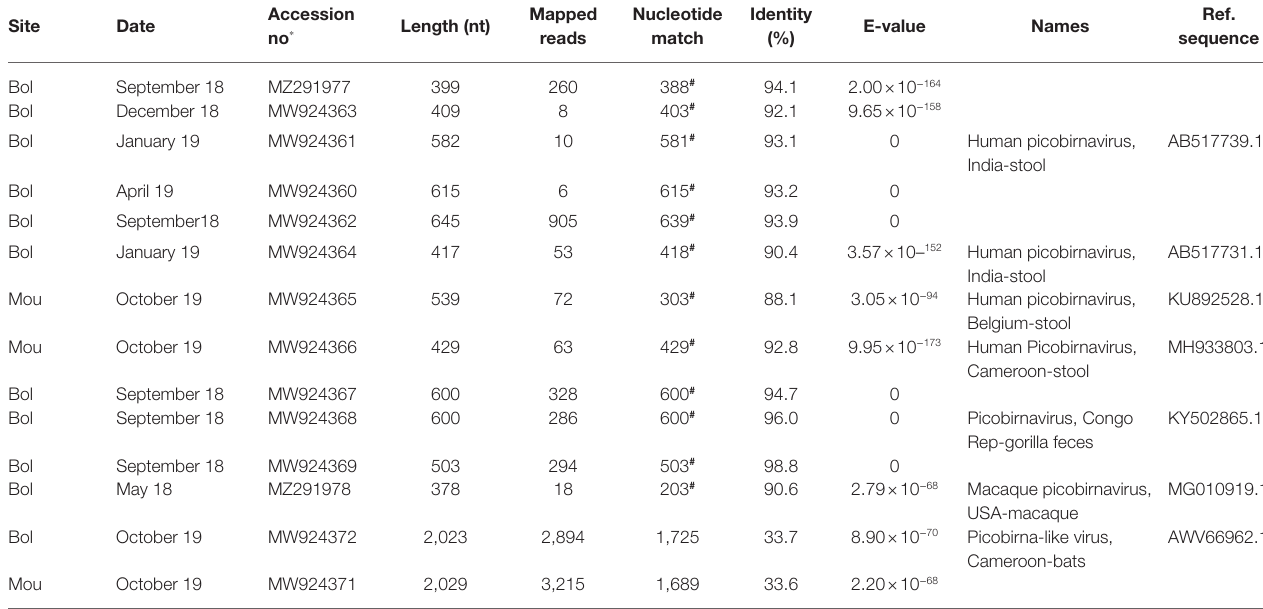
TABLE 5 | Picobirnaviridae sequences identified in Sanaga